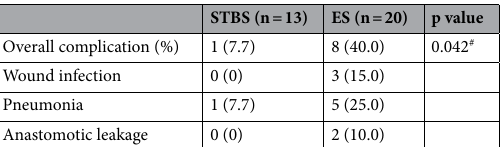
Table 3. Postoperative complications. *t test. # Chi-square test or fisher’s exact test.